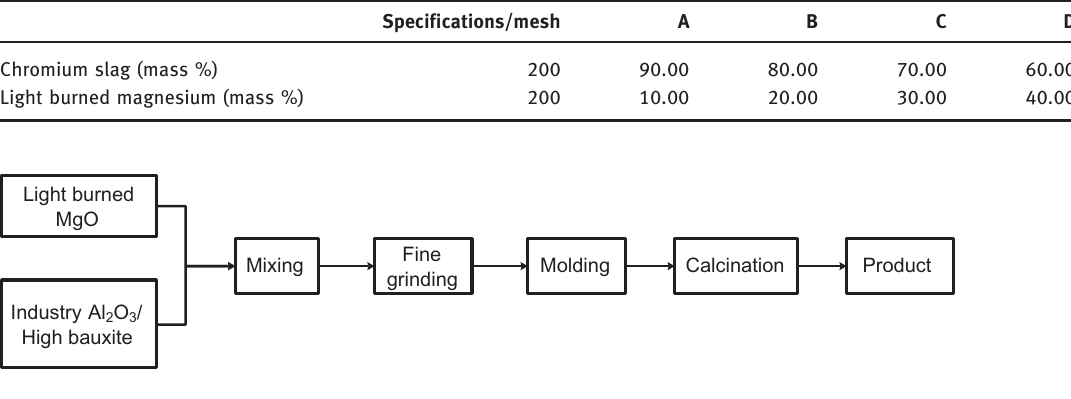
Figure 1: Flowchart of the preparation of MgAl 2 O 4 spinel by the sintering